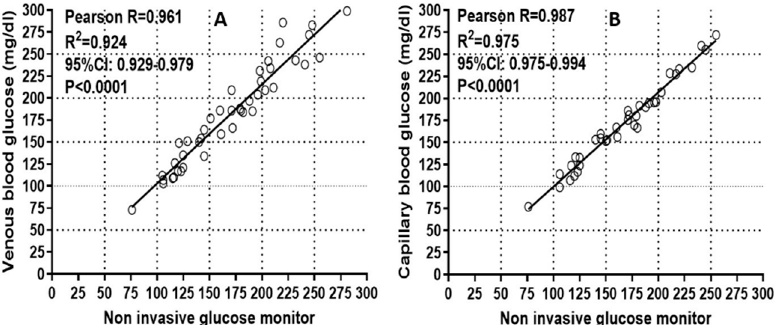
Figure 3. ( A ) Pearson correlation between HGR glucose meter readings and venous blood glucose readings by reference lab. ( B ) Pearson correlation between HGR glucose meter readings and capillary blood glucose readings by Abbott FreeStyle ® glucose meters.